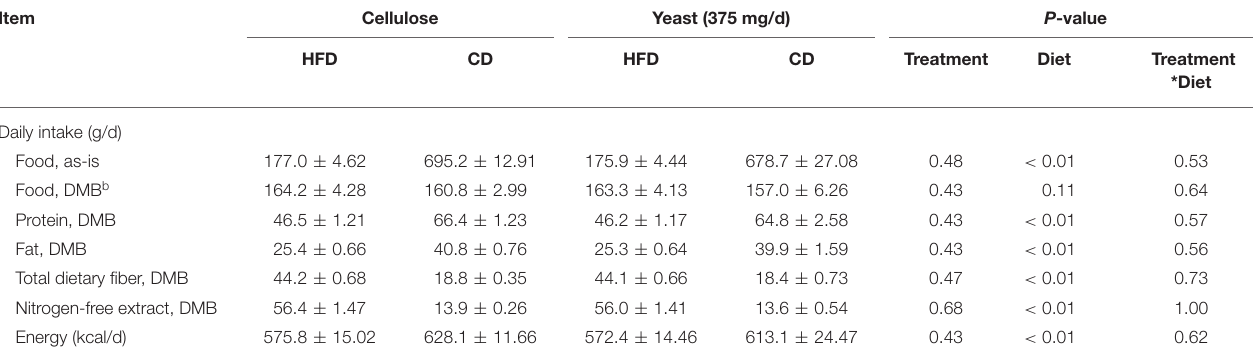
CD Treatment Diet Treatment *Diet